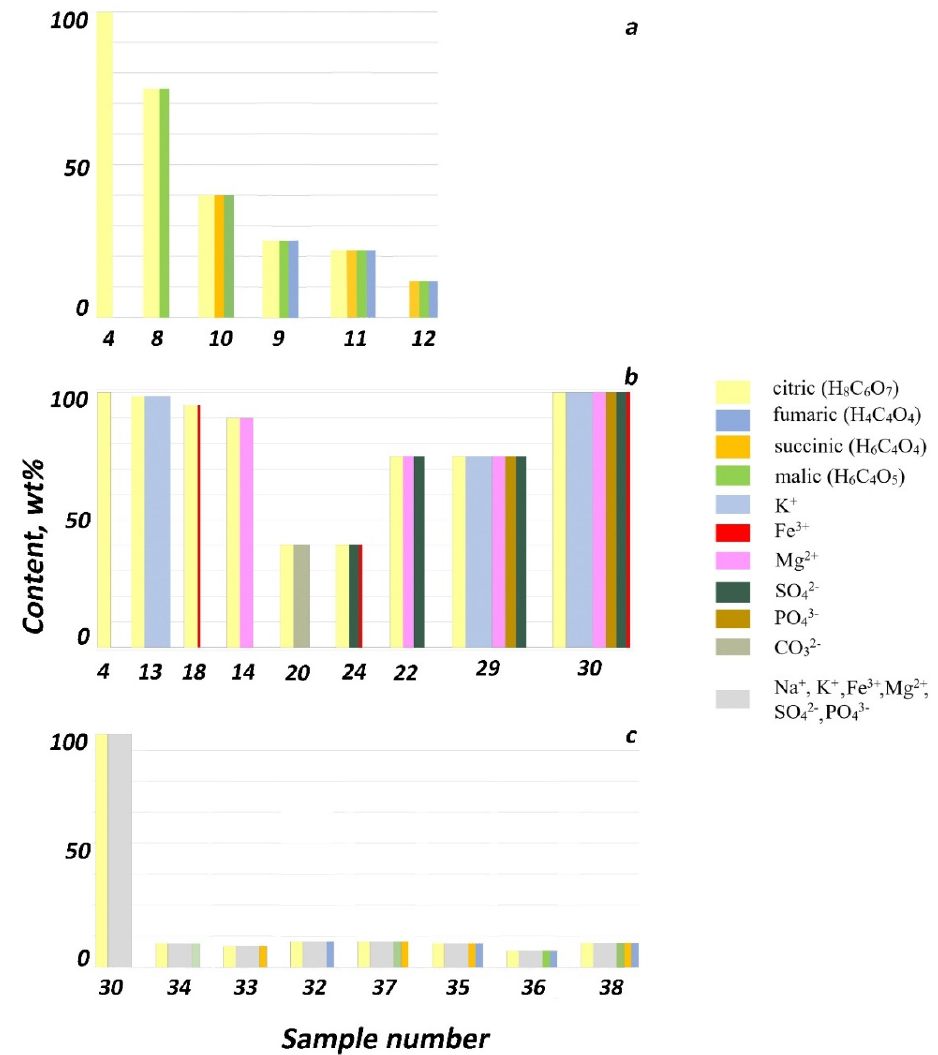
Figure 1. The content of weddellite in precipitate (obtained via XRPD) in the presence of different additives in solution: ( a ) organic acids, ( b ) citric acid and environmental ions and ( c ) organic acids and environmental ions. Sample numbers correspond to Appendix A Tables A1 and A2. Pillar thickness corresponds to the relative concentration of the additive in the solution. The mixture of environmental ions in ( c ) is grayed for the ease of diagram reading.